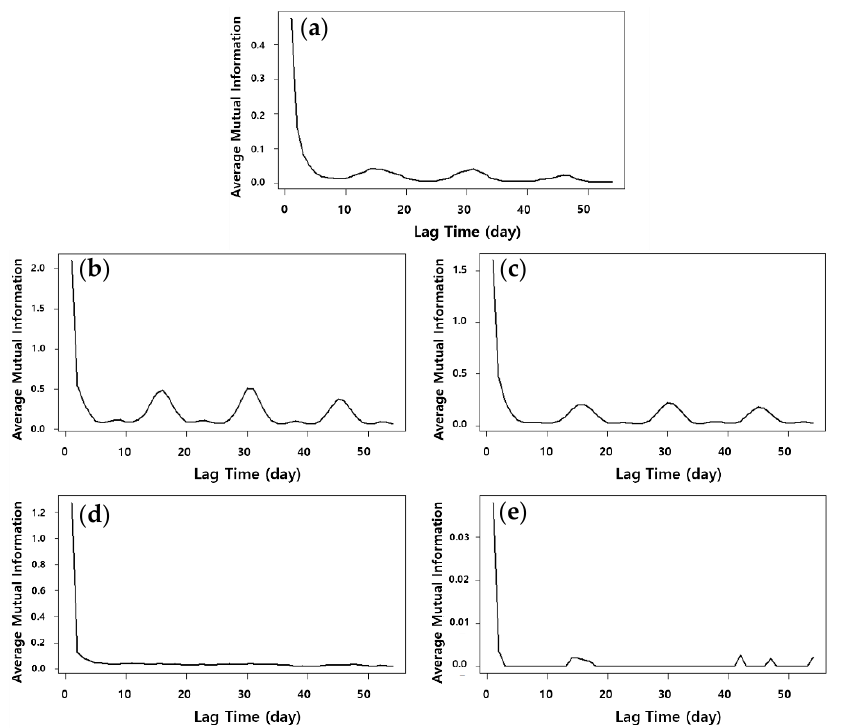
Figure 6. Average mutual information of each component: ( a ) water level, ( b ) tide component, ( c ) wave component, ( d ) noise component, ( e ) rainfall-runoff component. Table 3. Estimated delay times by the autocorrelation function(ACF)and average mutual information.